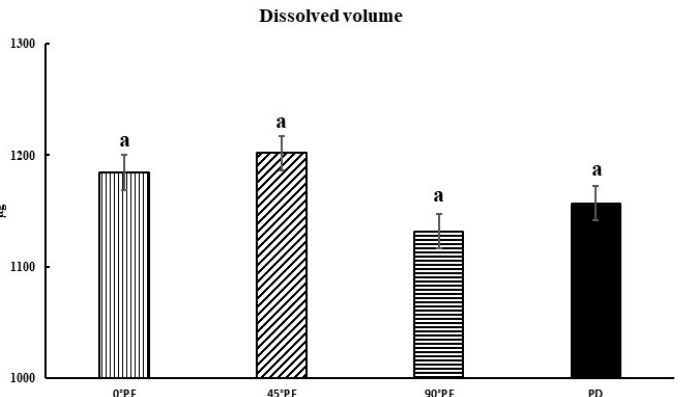
Figure 4. Water absorption results ( p < 0.05, I: 95% confidence interval standard deviation); there is no statistically significant difference between results indicated by “a”.